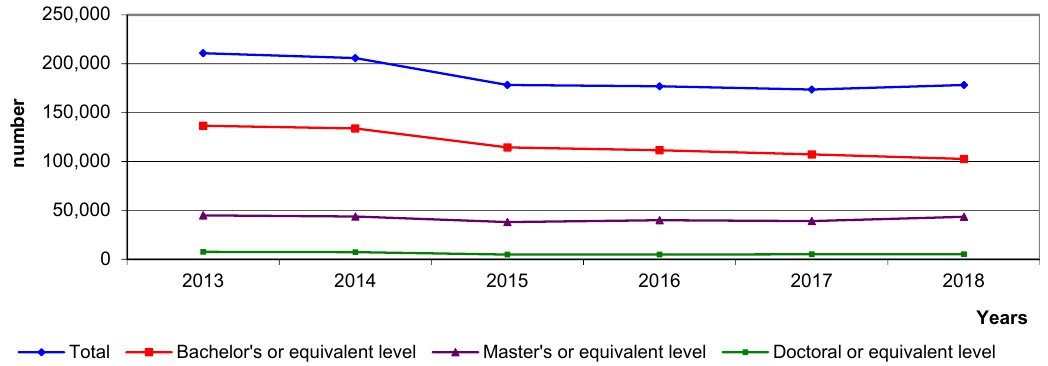
Figure 1. Number of students studying electricity and energy in 2013–2018.